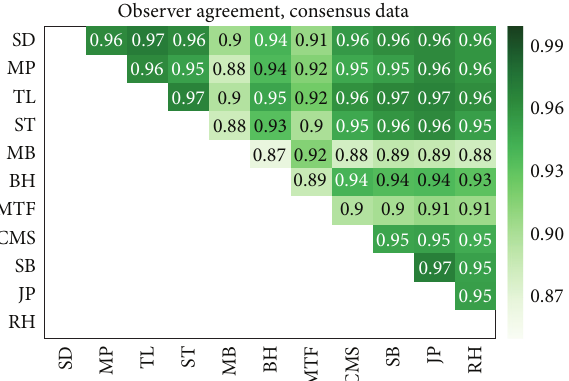
Figure 4: The agreement between observers for the 502 data points of the consensus data